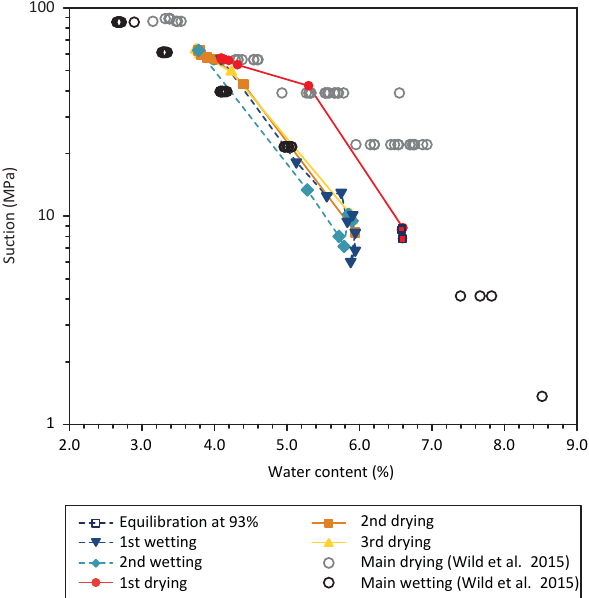
tion as a function of the water content. Also shown are the water retention curves (main drying and main wetting) reported by Wild et al. (2015) for specimens which were equilibrated to the applied level of RH at any